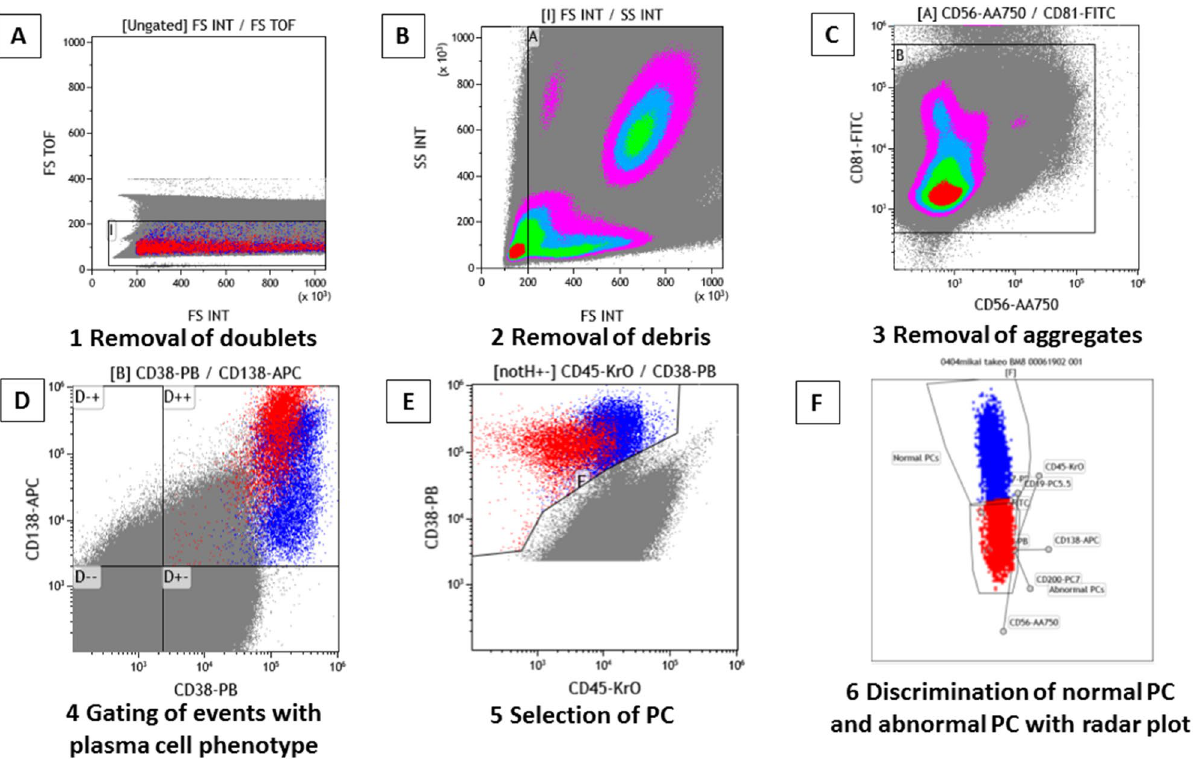
Figure 1. Overview of the gating strategy of plasma cells (PCs) and discrimination of normal and abnormal PCs with radar plot by DuraClone method in patients who did not receive anti-CD38 antibody. Light scatter characteristics are used to exclude doublets with high time of flight (TOF) ( A ), debris with lower scatter peak than lymphocytes ( B ) and aggregates with high fluorescent events with CD81-FITC and CD56-APC-A750 ( C ). All possible plasma cells are captured by gating CD38 + and CD138 + bright events ( D ). PCs are selected with CD38 high events using CD45 ( E ). Abnormal PCs are detected with radar plot ( F ). Red dots: myeloma